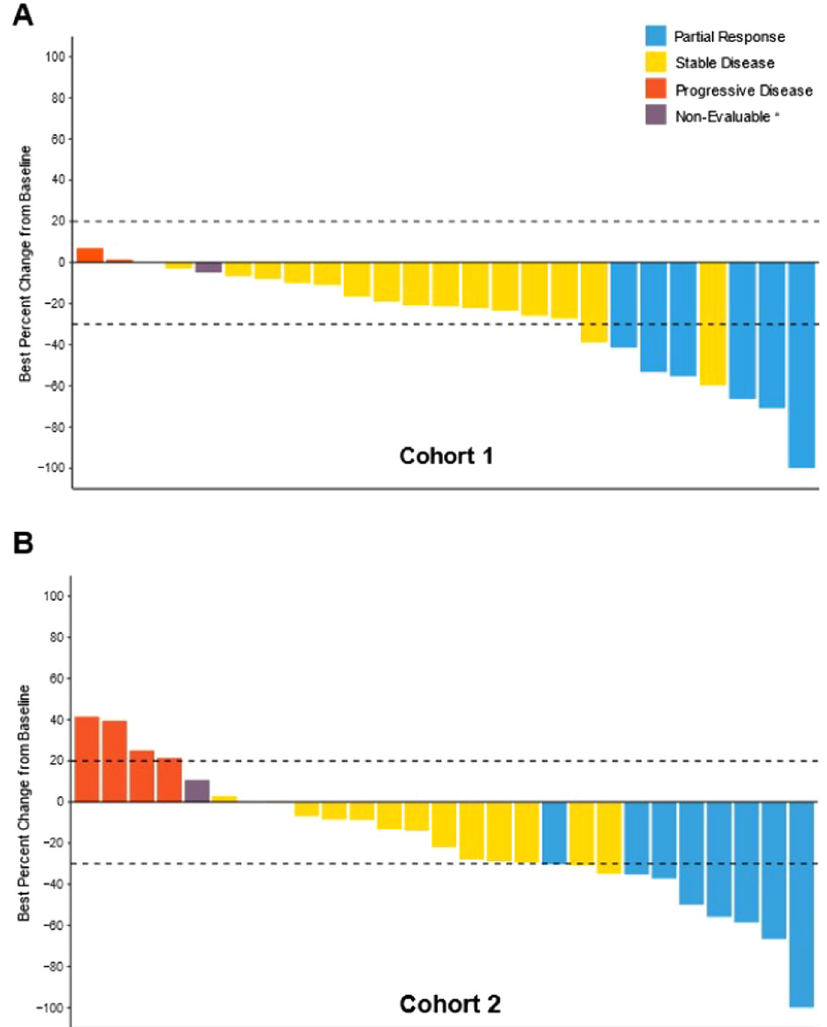
Fig. 1 Best percent change in tumor size from baseline according to RECIST 1.1. Best percent change in tumor size from baseline is presented for the safety populations in cohort 1 ( A ) and cohort 2 ( B ). Best overall responses presented here are con fi rmed responses. a Patients without any post baseline data are not included in the